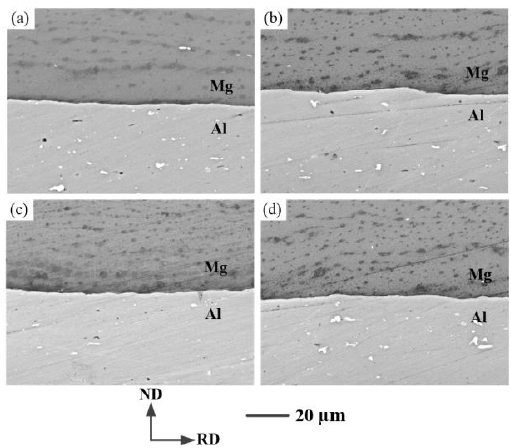
Figure 4. Interface SEM images of the corrugated Mg/Al clad sheet: ( a ) front waist, ( b ) peak, ( c ) back waist, ( d ) trough.